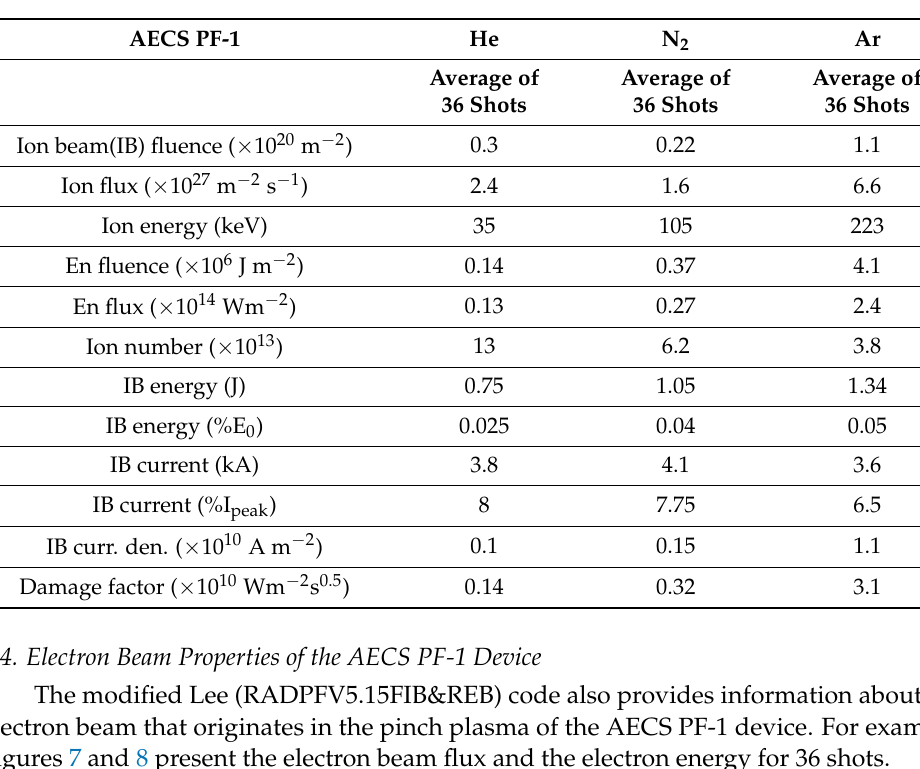
Figure 8. Electron energy for 36 shots of AECS PF-1 at 0.6 Torr for He, N 2 , and Ar gases. The mean values of the generated electron beam features for each gas are shown in Table 4. It shows that the fluence and flux increased with the higher atomic number, and reached a peak of 9.7 × 10 22 m − 2 and 5.9 × 10 30 electrons m − 2 s − 1 for argon, respectively. The electron number ranged from 2.7 × 10 14 (for He) to 5.5 × 10 14 ( for Ar). The beam energy also had a value of 2 J (0.072%E 0 ) for argon, 1.25 J (0.045%E 0 ) for nitrogen, and 0.78 J (0.03%E 0 ) for helium. The results presented the highest values of 2.2 × 10 16 Wm − 2 for the power flow density (heat flux), and adamage factor of around 3×10 12 Wm − 2 s 0.5 at 0.6 Torr of argon due tothe radiatively enhanced compression. The electron currents had values from 3.9 kA for helium (8.12% I peak ) to 5.2 kA (9.4% of I peak ) for argon. The kinetic energy of the relativistic electrons was found to be within the range of 18–23 keV.